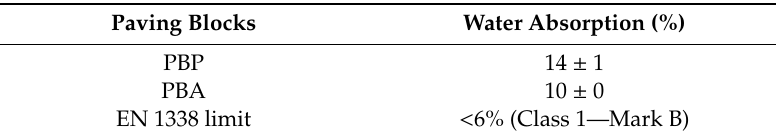
Table 4. Water absorption tests results and standard